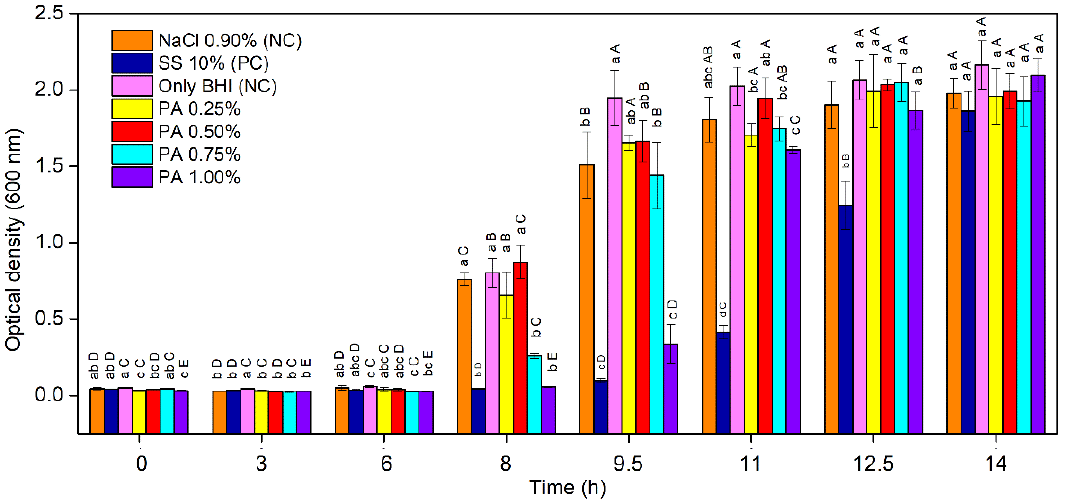
Figure 1. The effect of phytic acid (PA; 0%, 0.25%, 0.5%, 0.75%, and 1%), sodium sorbate (SS; 10%), and NaCl (0.9%) on the development of C. perfringens spores; PC: positive control; NC: negative control. The error bars represent the standard error ( n = 3); different lowercase letters indicate statistically significant differences by Tukey’s test among samples at the same time ( p < 0.05); different uppercase letters indicate statistically significant differences by Tukey’s test among the same sample at different times ( p < 0.05).